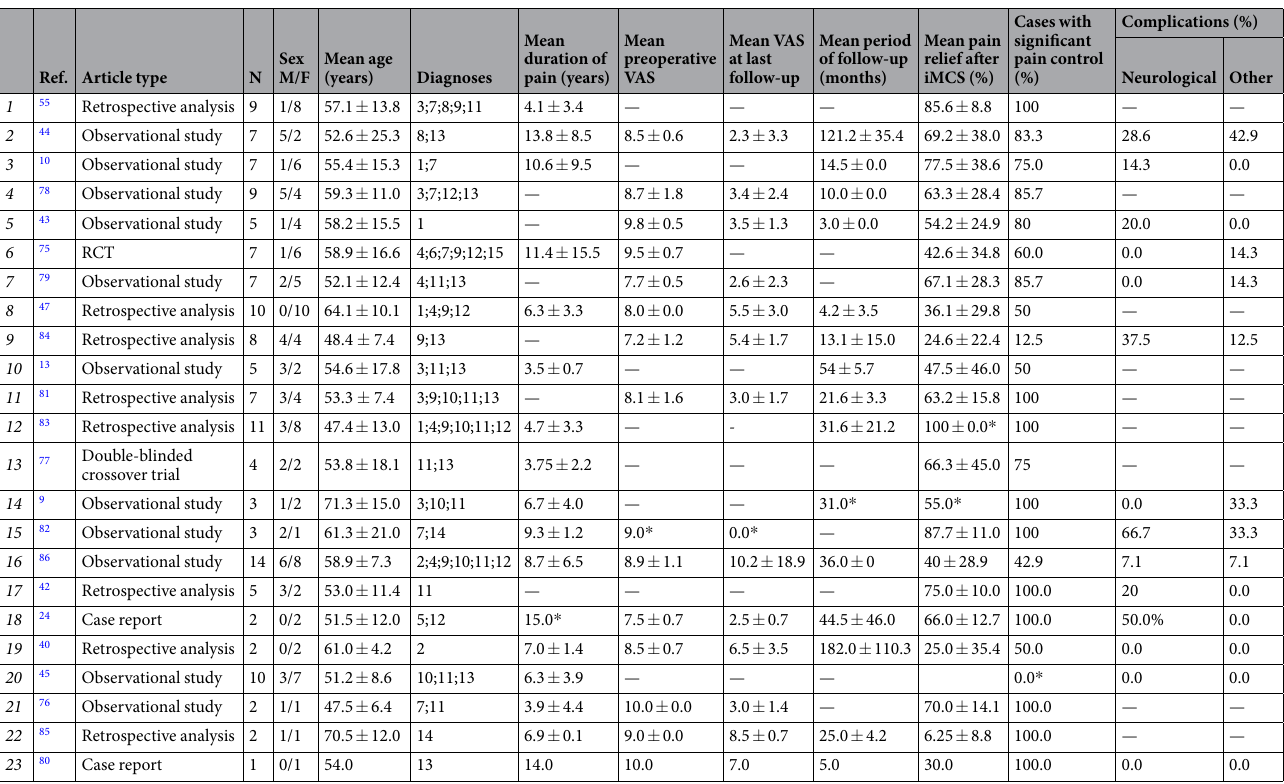
Table 2. Characteristics from patients suffering from trigeminal neuropathic pain derived from the available eligible publications (non-imputed data). 1 = Anesthesia dolorosa; 2 = Atypical facial pain; 3 = Brainstem lesion; 4 = Dental avulsion pain; 5 = Glossopharyngeal neuralgia; 6 = Neurofibromatosis type 1; 7 = Post- herpetic neuropathic pain; 8 = Post-neurosurgical pain; 9 = Post-surgical pain; 10 = Post-traumatic pain; 11 = Symptomatic trigeminal neuralgia; 12 = Trigeminal neuralgia; 13 = Trigeminal neuropathic pain; 14 = Trigeminal deafferentation pain; * = limited subjects in subanalysis due to missing information; VAS = Visual analogue scale; − =